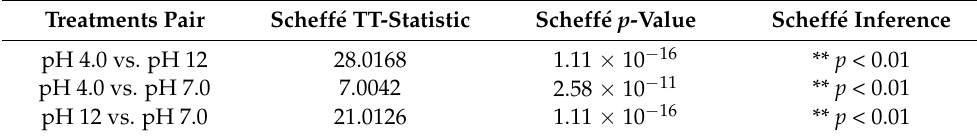
Table 6. Analysis of variance using the Scheff é method based on concrete strength data. Treatments Pair